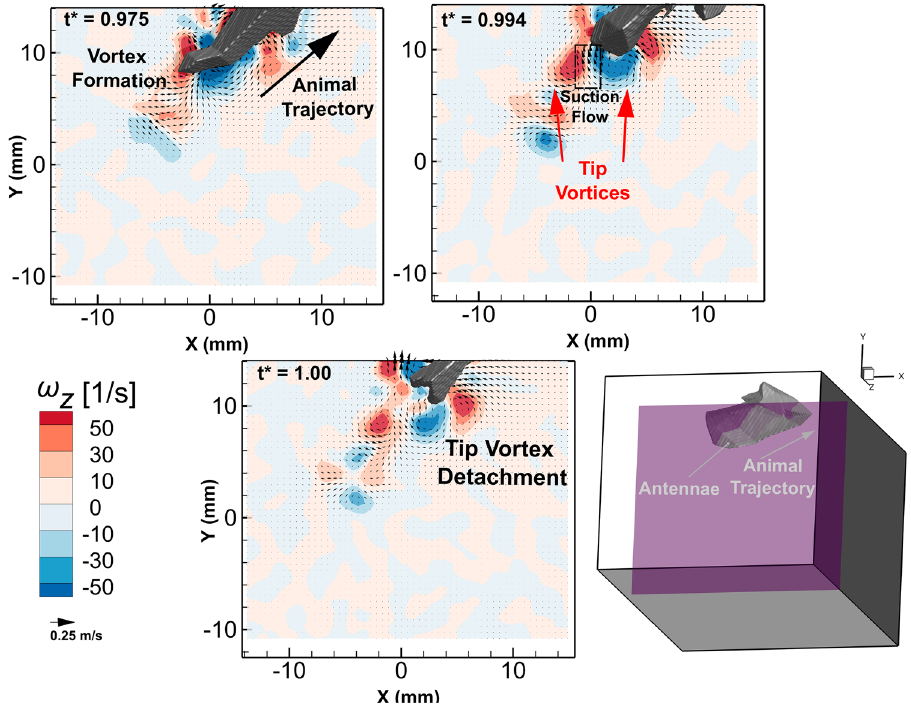
Figure 7. Time series of the z -component of vorticity, ω z , field in a XY plane (for Z = 6.36 mm) centered along the antennae and its wake while E. superba moves through the plane at maximum speed. The XY plane was extracted from the full 3D vector flow field. A small 3D reconstruction of the slice orientation with respect to the 3D visual hull is shown in the bottom